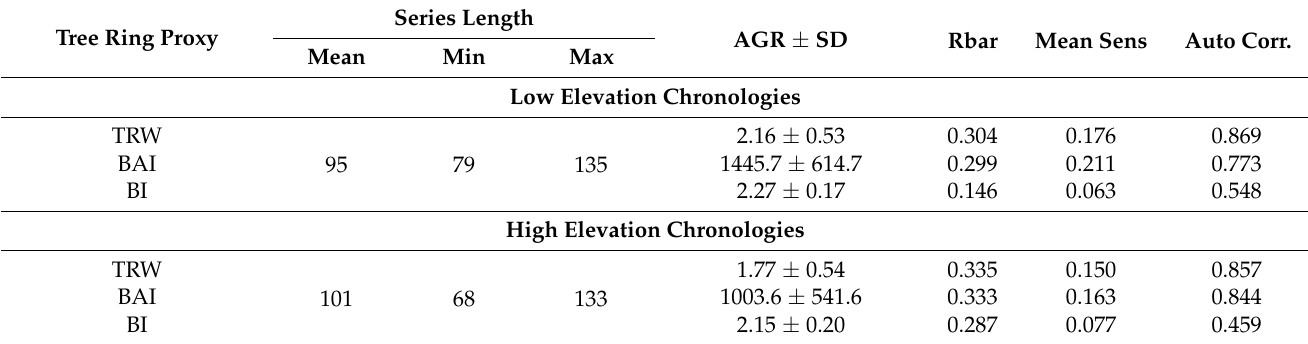
Table 1. Basis statistics for the six chronologies: TRW—tree-ring width; BAI—basal area increment;